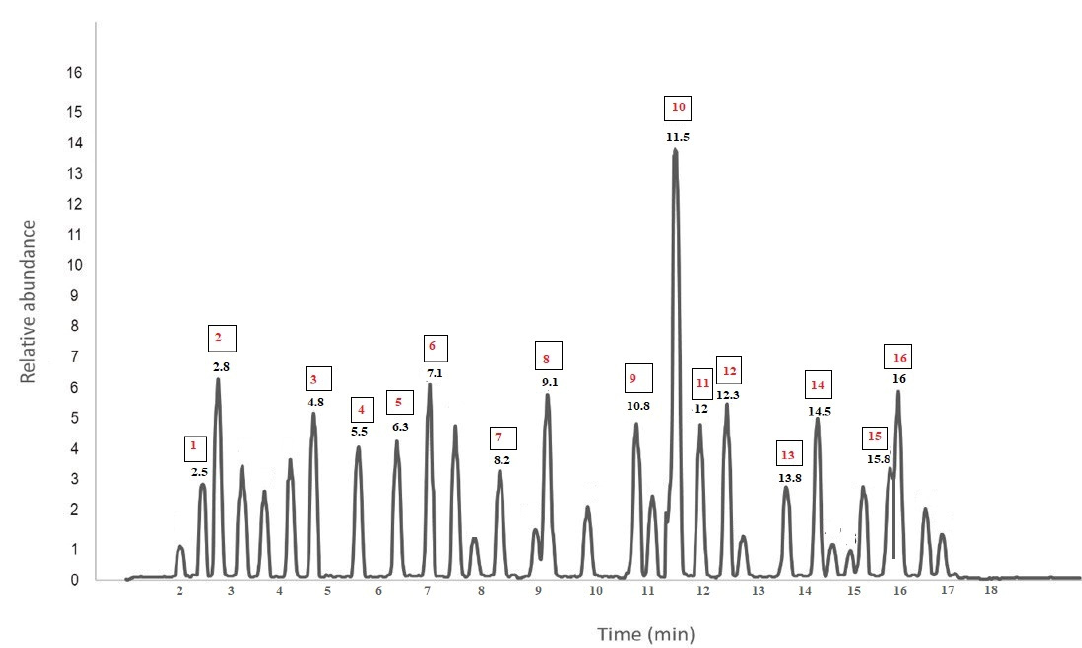
Figure 6. LC-MS chromatogram from R. officinalis extracts obtained by using DES2: Tailor.